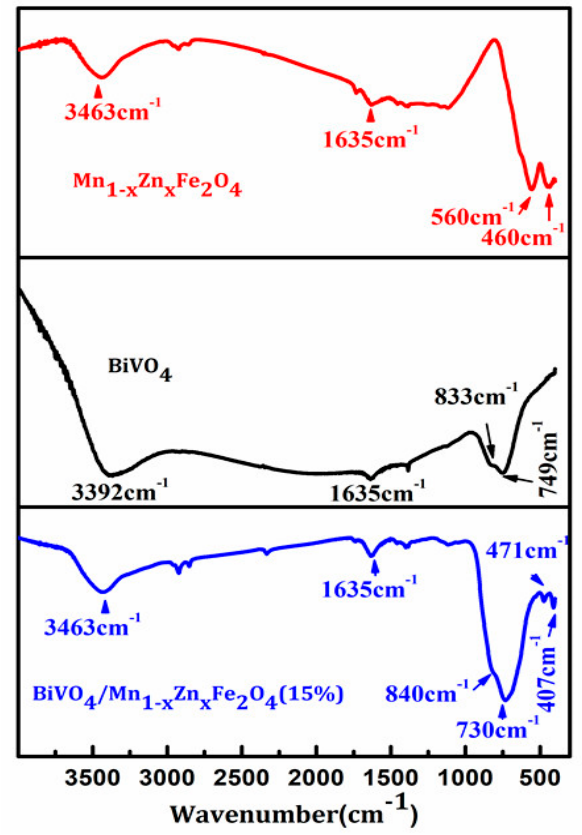
Figure 2. FTIR (Fourier transform infrared) spectrum of the prepared samples.